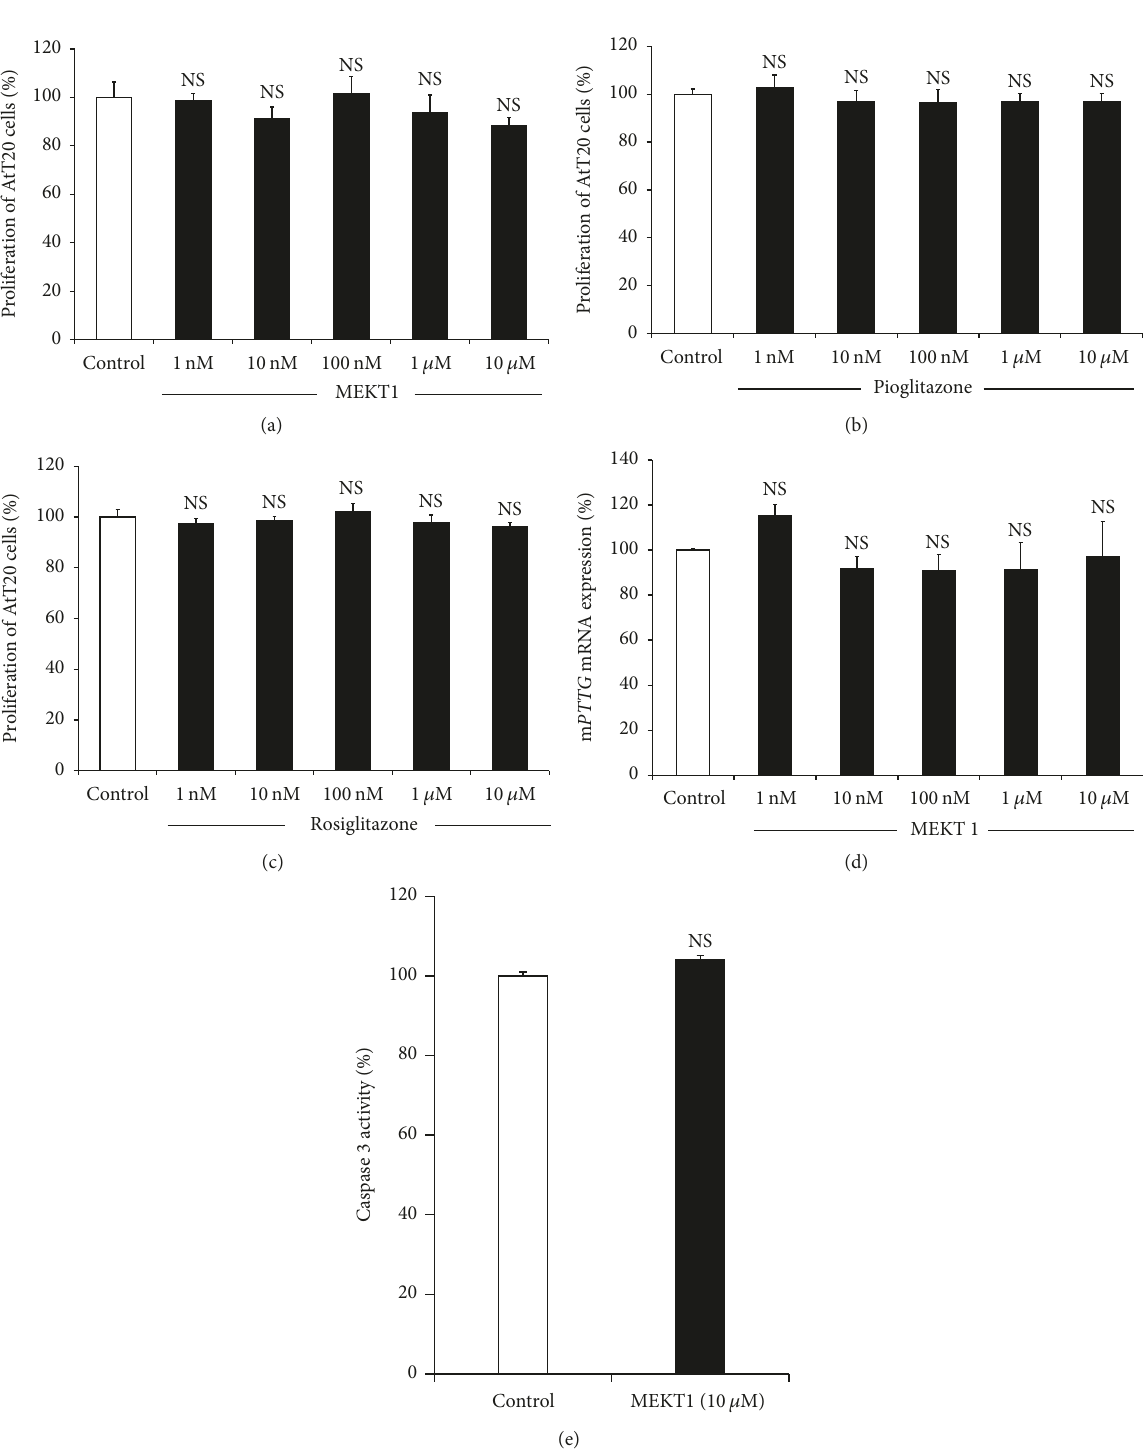
Figure 4: MEKT1-mediated effect on AtT20 cell proliferation and apoptosis. (a) AtT20 cells were incubated for 96 hours either in the presence of MEKT1 (1nM, 10nM, 100nM, 1 𝜇 M, or 10 𝜇 M) or DMSO (0.1%) as a control for 24 hours before assay. (b) AtT20 cells were incubated for 96 hours either in the presence of pioglitazone (1nM, 10nM, 100nM, 1 𝜇 M, or 10 𝜇 M) or DMSO (0.1%) as a control for 24 hours before assay. (c) AtT20 cells were incubated for 96 hours either in the presence of rosiglitazone (1nM, 10nM, 100nM, 1 𝜇 M, or 10 𝜇 M) or DMSO (0.1%) as a control for 24 hours before assay. Data are expressed as percentages (100%) of control. (d) Effects of MEKT1 on mRNA expression of m Pttg dose-dependently. AtT20 cells were treated with MEKT1 (1nM, 10nM, 100nM, 1 𝜇 M, or 10 𝜇 M) or 0.1% DMSO (vehicle control) for 24 hours. (e) Effects on MEKT1 (10 𝜇 M) on AtT20 cell apoptosis. Each point indicates mean ± SEM ( 𝑛 = 4 ). NS stands for “not